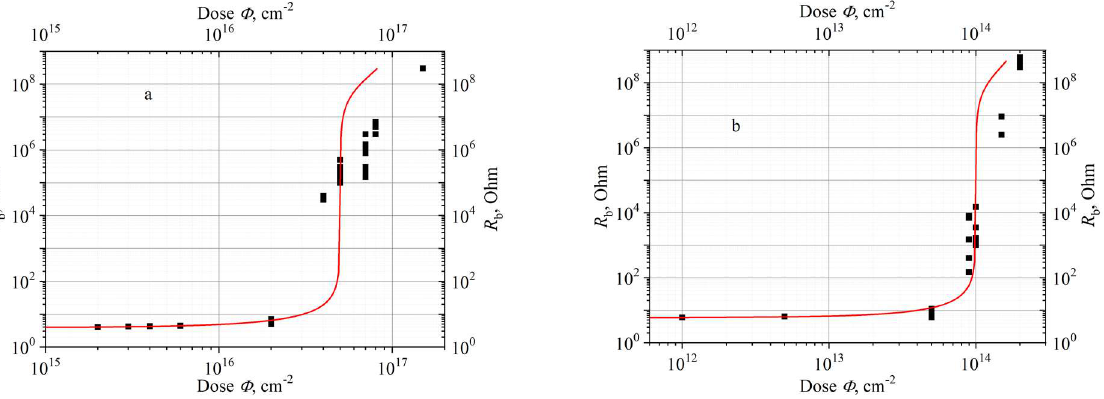
Figure 2. Experimental [9] and calculated (Equation (3)) dependences of the base resistance of 600 V 4H-SiC Schottky diodes, R b , on the dose Φ when irradiated with electrons with an energy of 0.9 MeV ( a ) and protons with an energy of 15 MeV ( b ). Points present experimental data, lines correspond to calculations.